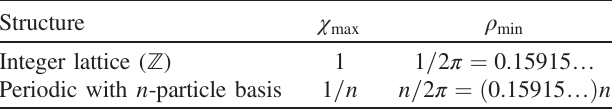
TABLE I. Maximum values of χ and corresponding minimum values of ρ for certain periodic stealthy ground states in R with K ¼ 1 . The configuration with the largest possible value of χ max (smallest possible value of ρ ) corresponds to the integer lattice. min ρ Structure χ max min Integer lattice ( Z ) 1 1 = 2 π ¼ 0 . 15915 … Periodic with n -particle basis 1 =n n= 2 π ¼ ð 0 . 15915 … Þ